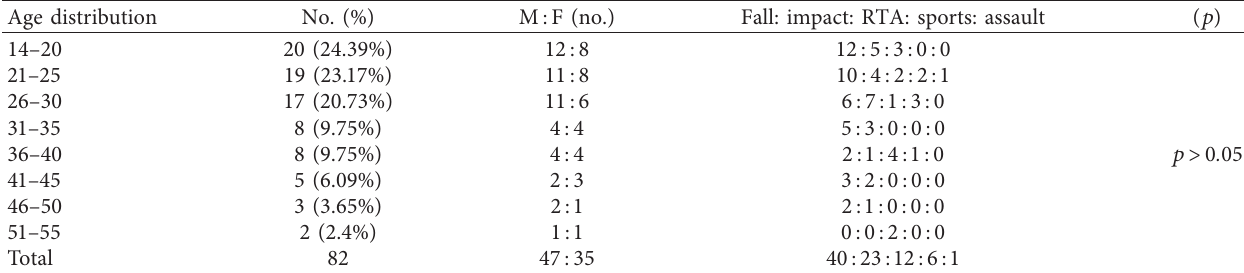
Table 1: Distribution of age, gender, and etiology.